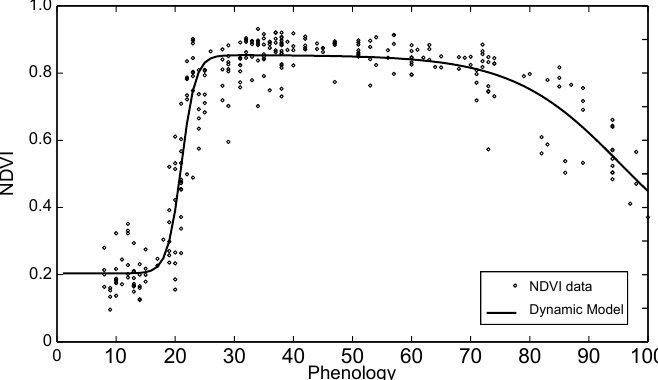
Figure 3. Measurements of NDVI (observations) for different parcels at different years represented as a function of phenological state (black circles). The solid line corresponds to the observation model, i.e., the NDVI value for each phenological state given by Equation (16). r 1 = 0.84, f 1 = 21.07, r 2 = − 0.10, f 2 = 95.40, c = 0.21, d = 0.65 and b = 73.8626